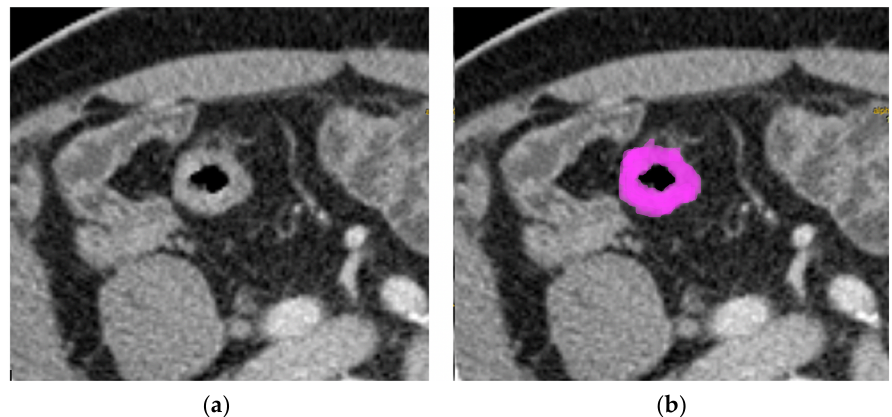
Figure 1. Tumor tissue in the axial CT portal venous phase images in locally advanced CRC in a 77-year-old man ( a ). The pink area represents the regions of interest; the procedure was applied for every single slice where the tumor was detectable, obtaining a 3D-ROI ( b ).